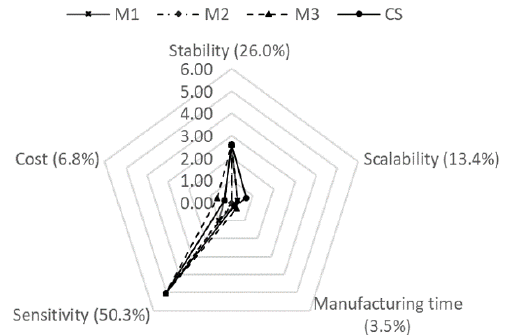
Figure 8. Radar chart for oxygen sensors scores with respect to the analytic hierarchy process criteria.